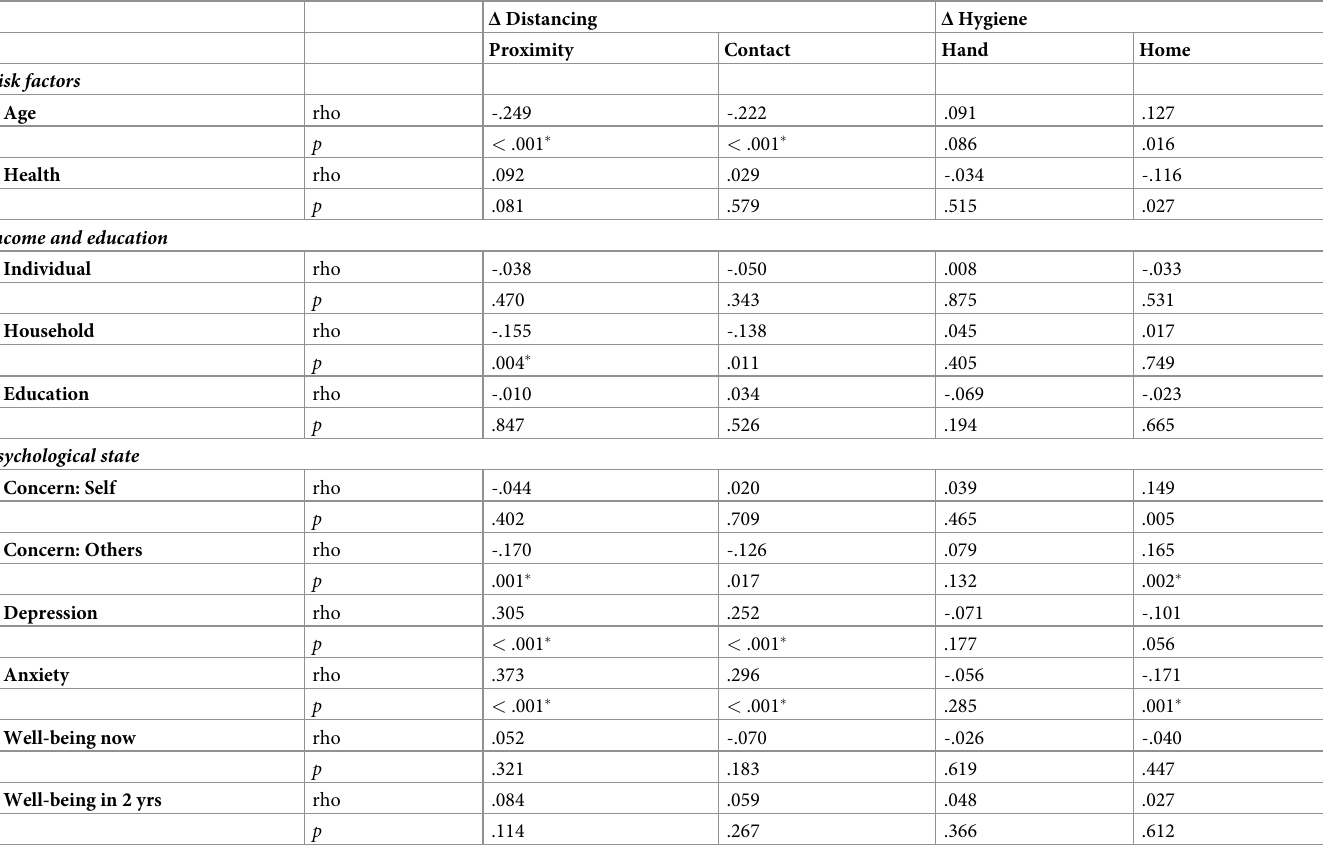
Table 5. Correlations of changes in mitigation behaviors with potential associates.